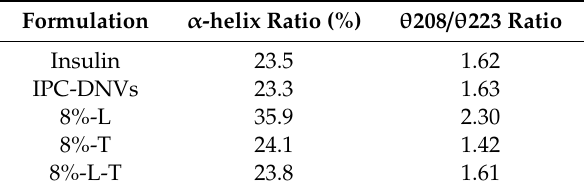
Table 6. α -helix and θ 208 / θ 223 ratios of lyophilized